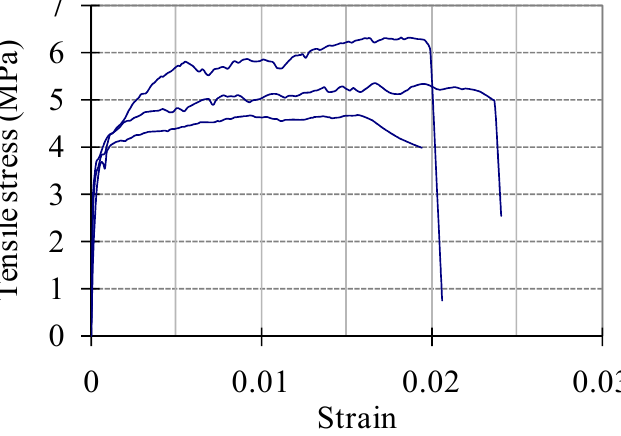
Figure 3. Stress–strain behavior of HPFRCC in uniaxial